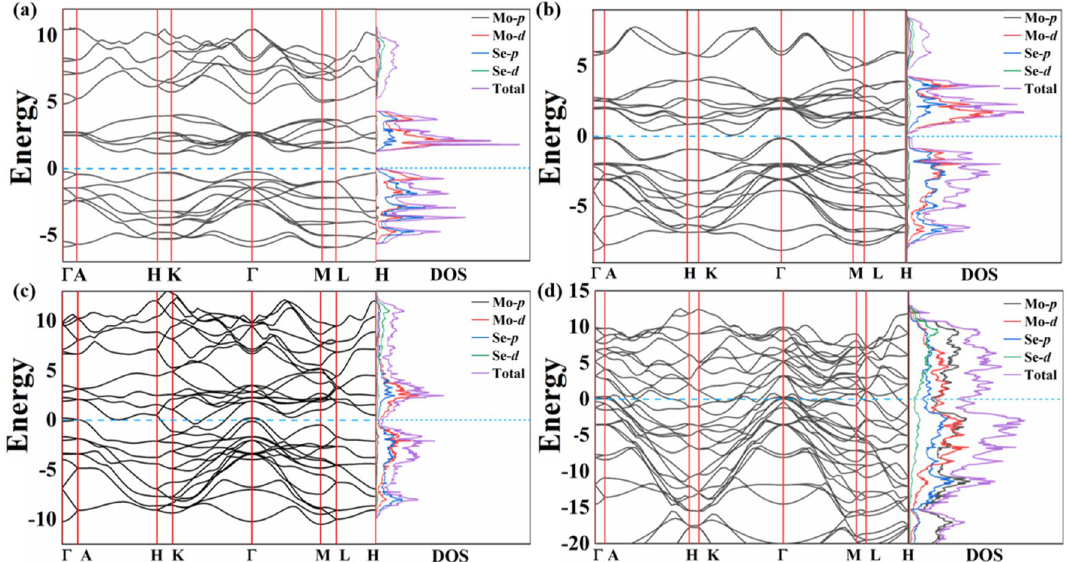
Figure 4. Band structure and projected density of states of MoSe 2 . ( a ) P 6 3 /mmc phase at 0 GPa, ( b ) R 3 m phase at 20 GPa, ( c ) P 6 3 /mmc phase at 80 GPa, and ( d ) R -3 m phase at 500 GPa,